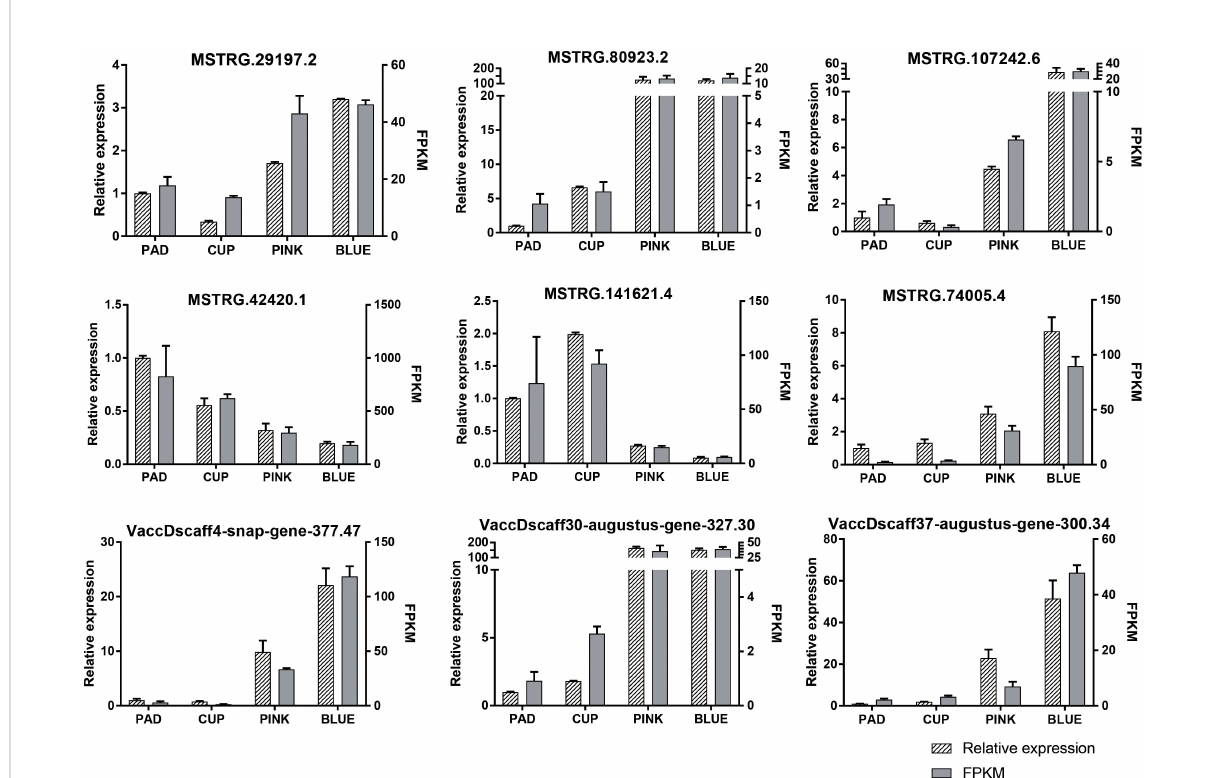
FIGURE 4 Expression patterns of nine randomly selected transcripts validated by qRT-PCR. The relative expression and fragments per kilobase million (FPKM) are both